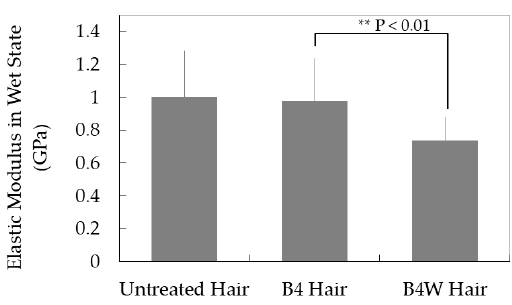
Figure 3. Elastic modulus measured by atomic force microscopy (AFM) nanoindentation in wet environment. Five hair fibers for untreated hair, B4 hair, and B4W hair respectively were measured.